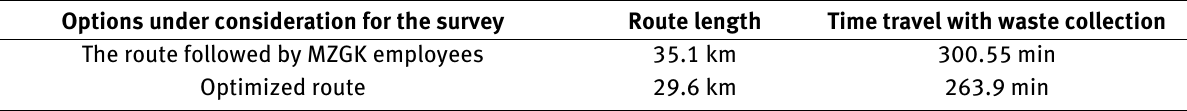
Table 5: Comparison of the length of the routes and their travel time for the compiled variants Options under consideration for the survey Route length Time travel with waste collection The route followed by MZGK